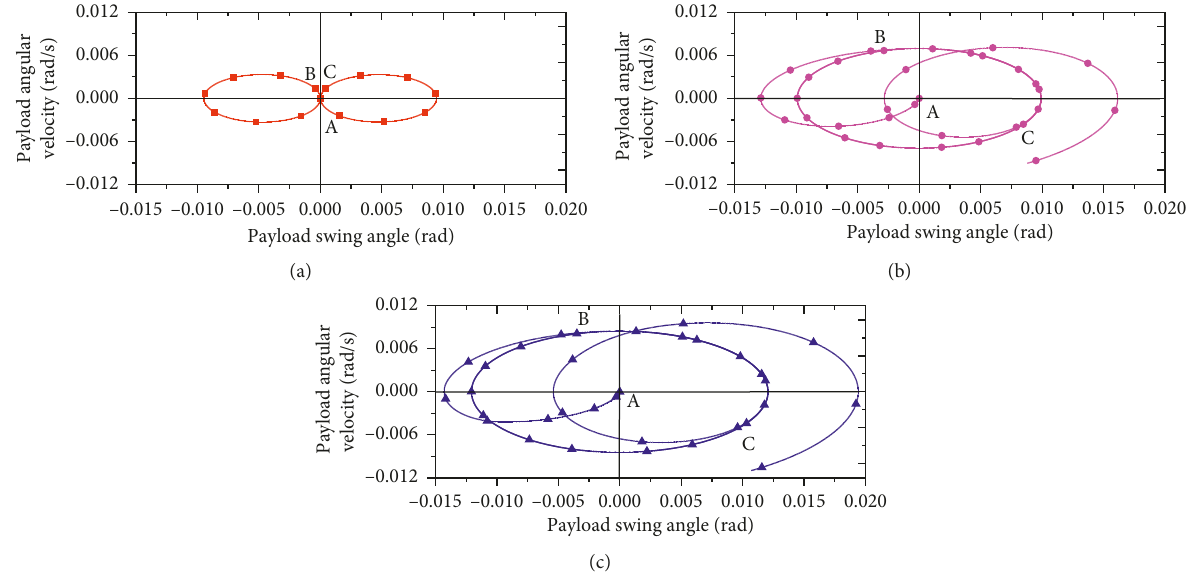
Figure 6: Phase plane illustrations for the three acceleration curves: (a) when trolley acceleration is constant; (b) when trolley acceleration is sine curve; (c) when trolley acceleration is ramp curve.